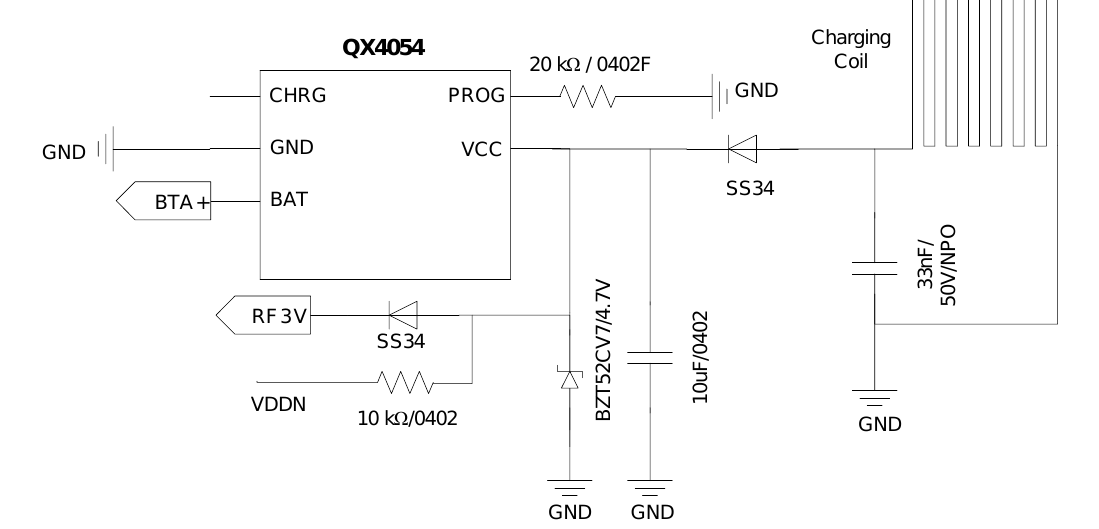
Figure 10. The lithium-ion battery recharging circuit.